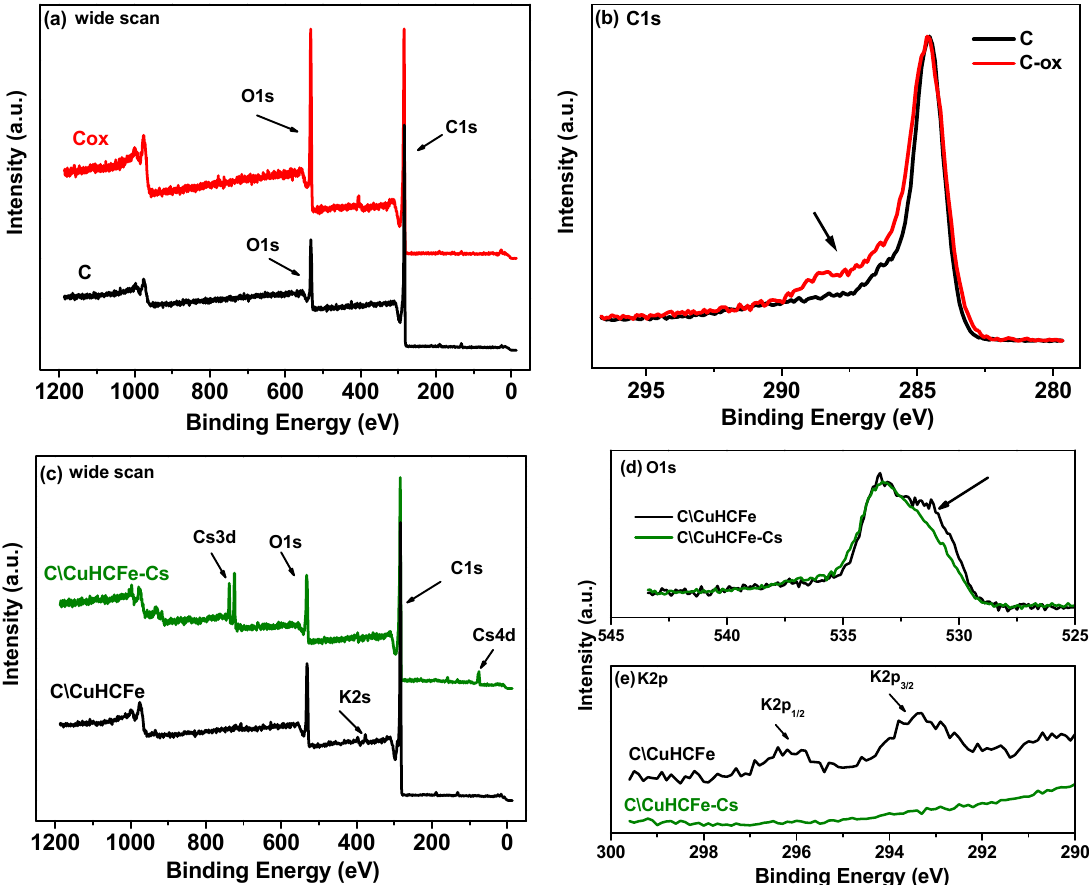
Figure 6. Wide scan ( a ) and C1s ( b ) core level XPS spectra of C and C-ox supports. Wide scan ( c ), O1s ( d ), and K2p ( e ) core level XPS spectra of C/CuHCFe and C/CuHCFe-Cs.